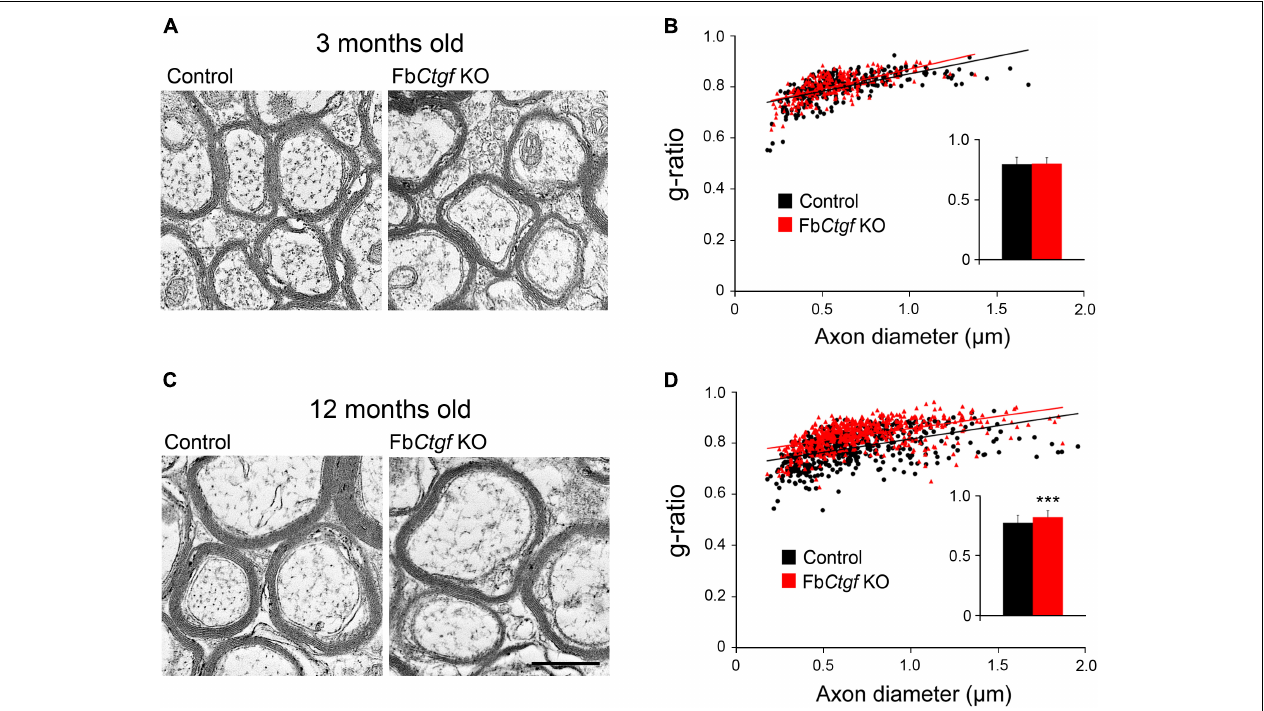
FIGURE 8 | Myelinated axons in the external capsule. Photomicrographs were taken from the external capsule underneath the somatosensory cortex of the young adult (A) and middle-aged (B) mice using a transmission electron microscope. The inner axonal diameter and outer myelin sheath diameter of each fiber were measured, and the g-ratio was determined ( n > 450 myelinated fibers from three mice per genotype in the young adult group and four mice per genotype in the middle-aged group). In the young adult group, no significant change in g-ratio was found between genotypes (C) . In the middle-aged group, a higher g-ratio was noted in Fb Ctgf KO mice relative to the age-matched control mice (D) . Scale bar is 500 nm. Results are means ± SEM ( ∗∗∗ p <